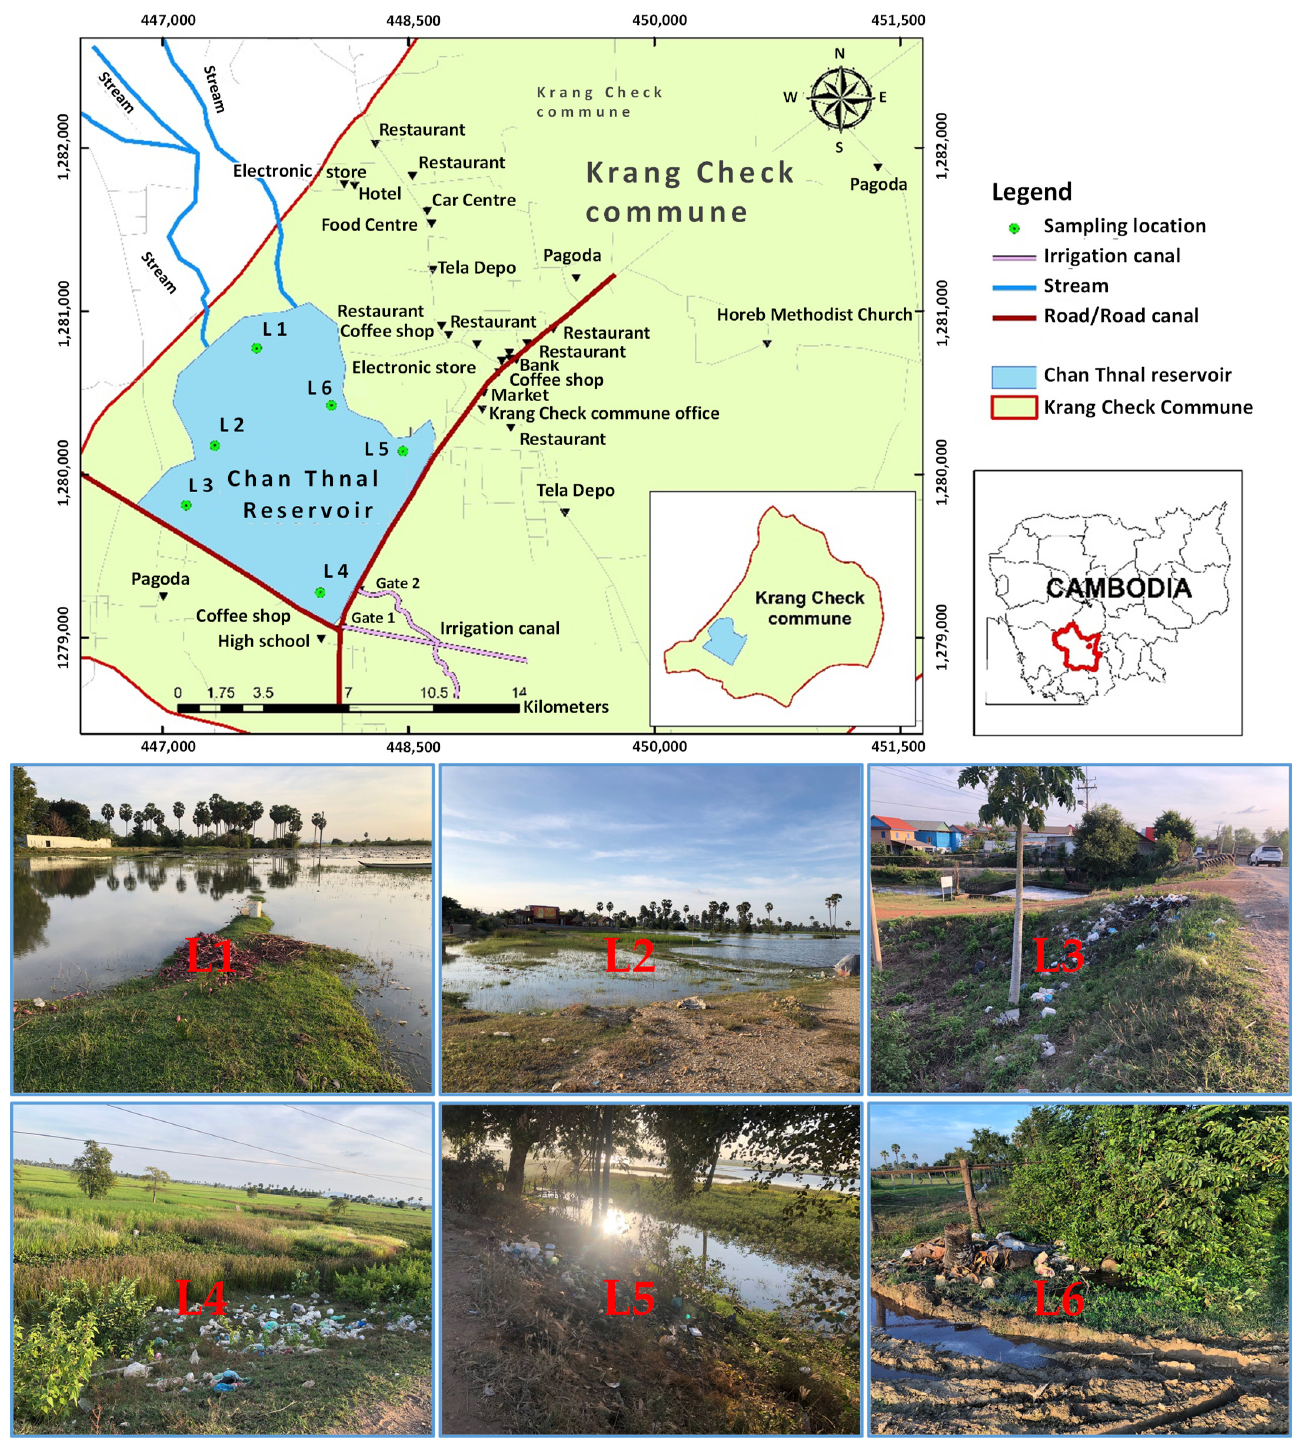
Figure 1. Sampling locations (L1 to L6) in the study area and the circumstance connected to each location (L1 to L6).